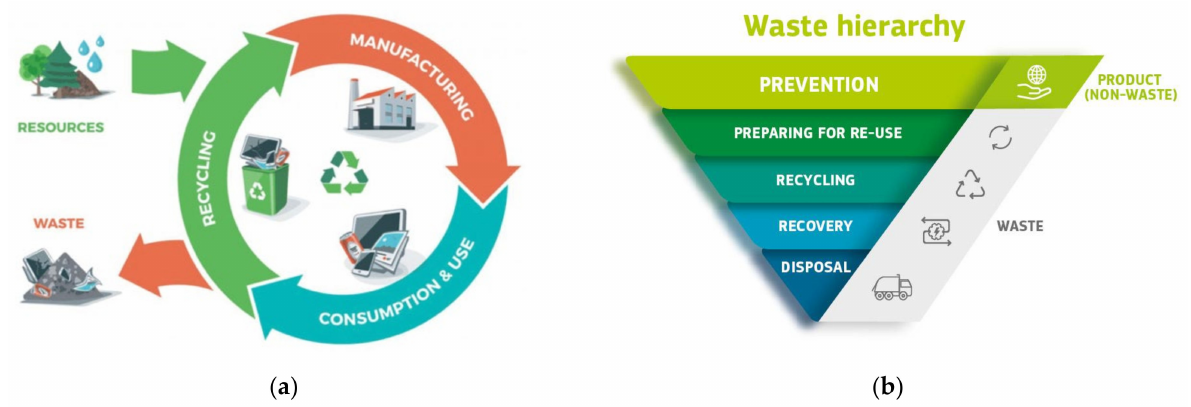
Figure 1. The illustration of the concept of ( a ) circular economy and ( b ) waste hierarchy. Source: Europa.eu (official website of European